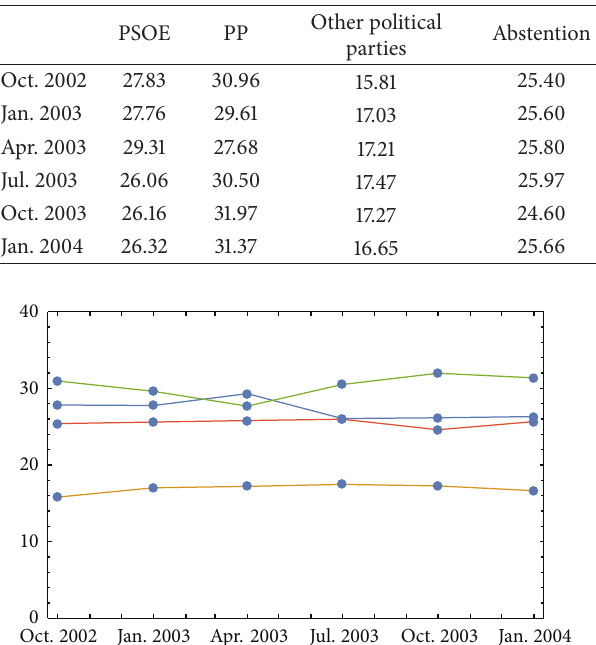
Table 1: Percentage of voting intention and abstention in CIS surveys from Oct. 2002 until Jan. 2004, the last one before elections of Mar. 14, 2004 [12].